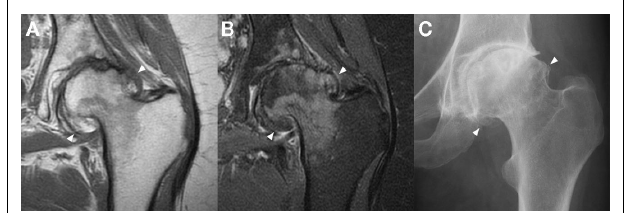
FIGURE 6 | Multi-detector CT multi-planar reformatting of the right hip viewed with a bone window (A) in the axial oblique, (B) coronal oblique, and (C) sagittal oblique planes with respect to the long axis of the femoral head and neck; (D) Shaded surface display 3D reconstruction of the same individual. Note the presence of degenerative osteophytes at the anterior femoral head–neck junction in (A,D) , early marginal osteophytes at the superior and inferior femoral head–neck junction in (B) and irregularity of the acetabular rim throughout. Images courtesy of the Department of Radiology, Addenbrooke’s Hospital,